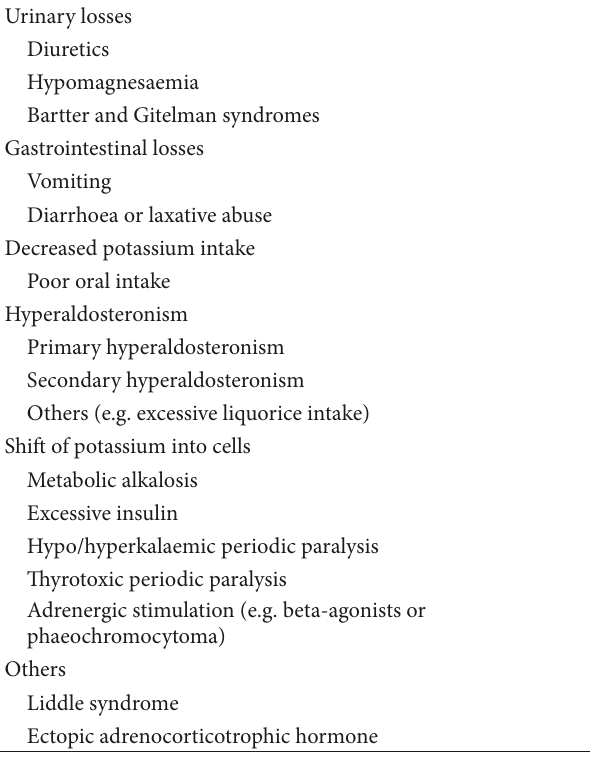
Table 1: Causes of